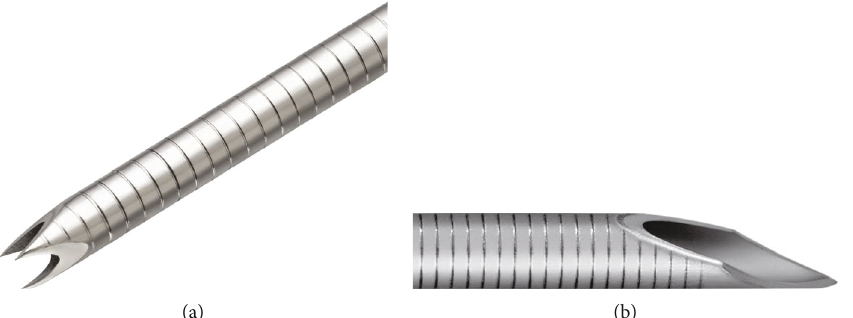
Figure 1: Endoscopic ultrasound-guided fi ne needles. (a) A Franseen needle with three symmetric cutting tips for endoscopic ultrasound- guided fi ne-needle biopsy (EUS-FNB). (b) A conventional needle for endoscopic ultrasound-guided fi ne-needle aspiration